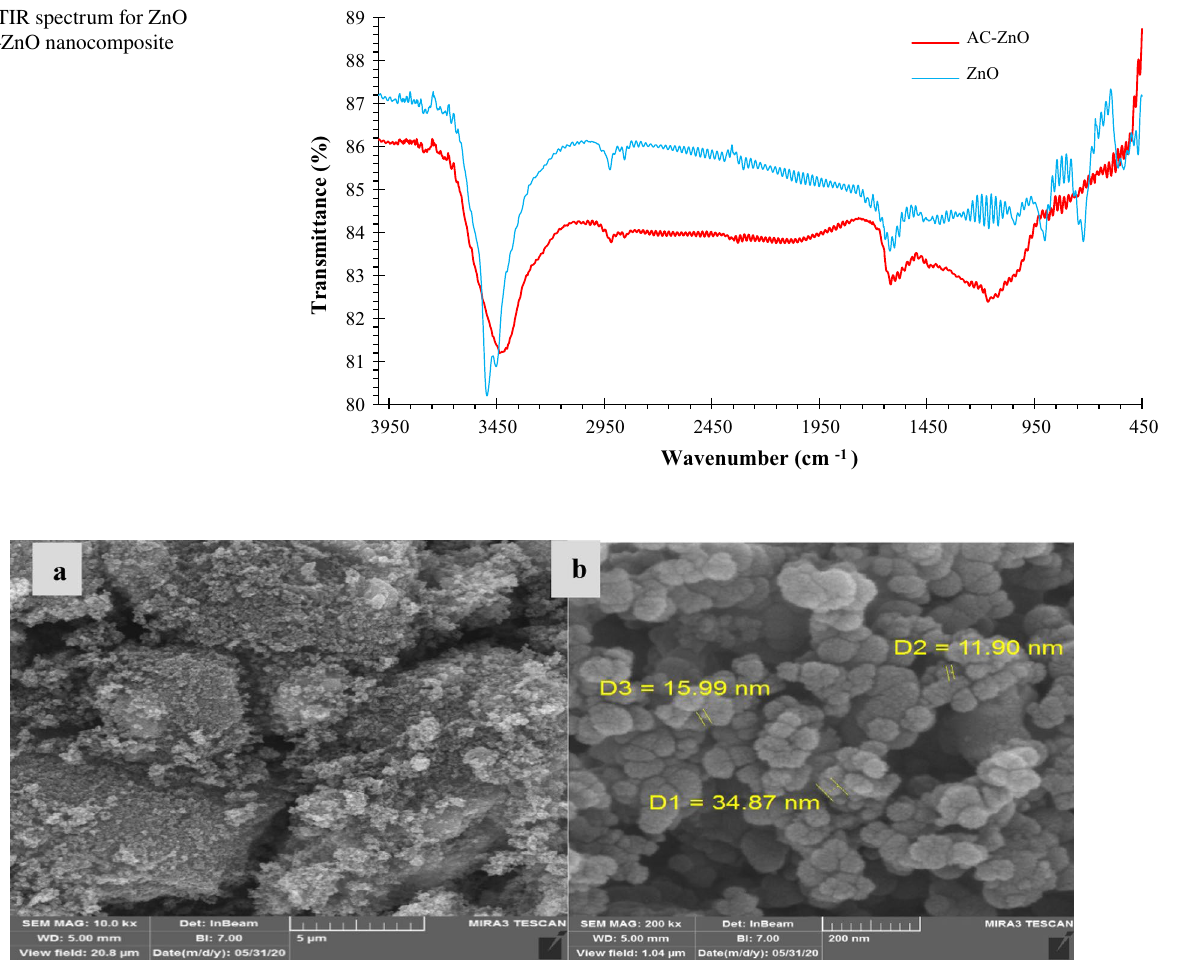
Fig. 3 FE-SEM pattern: ZnO ( a ) AC–ZnO nanocomposite ( b